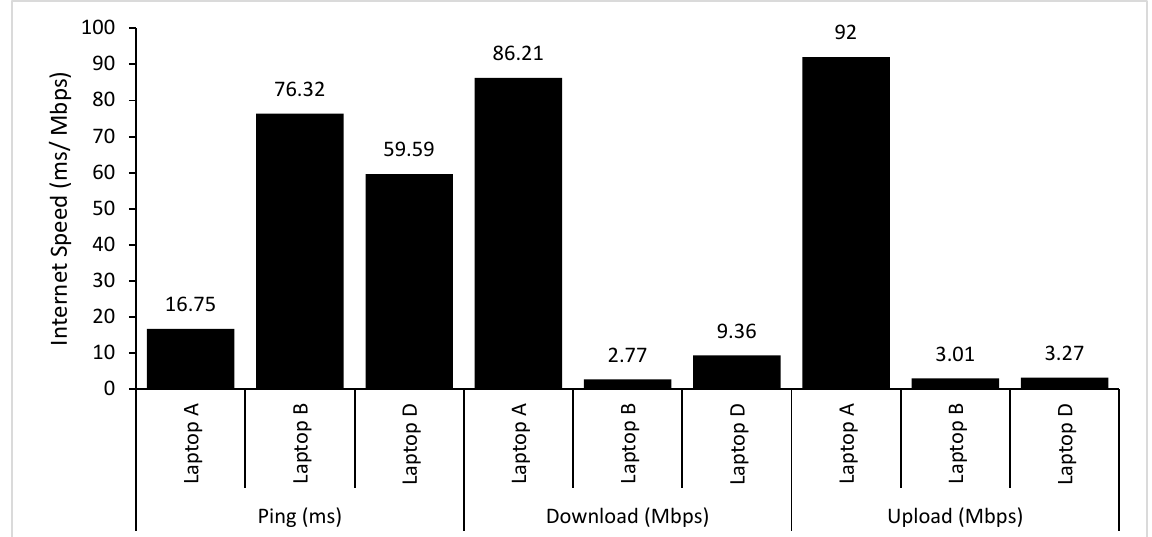
Figure A1. Audiology clinical examination setup.